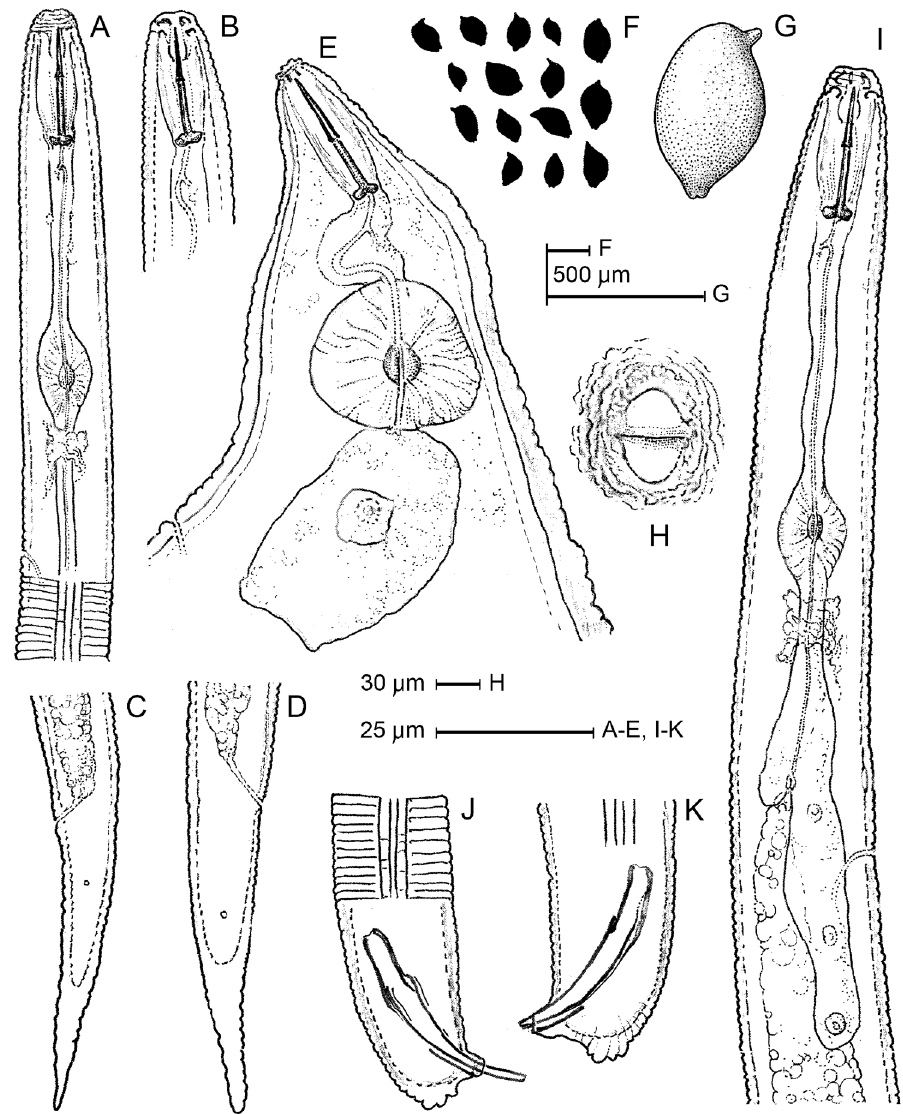
Figure 1. Line drawings of Heterodera fici from Italy. A, B Anterior body portions of second stage ju- venile C, D Second stage juvenile tail E Female anterior region F, G Cyst shape H Fenestral structures J, K Male tail, showing spicules and cloacal tube I Male pharyngeal region. J2 ( Second stagejuveniles ). Body vermiform; tapering at both extremities, more marked posteriorly. Cuticular annulation prominent. Lateral field with four incisures. Labial region slightly offset, rounded, with three or four annuli. Labial framework moderately sclerotised. Stylet well developed, basal knobs rounded, directed slightly anteriorly. Median bulb ovoid. Pharyngeal lobe usually distinct, with three large